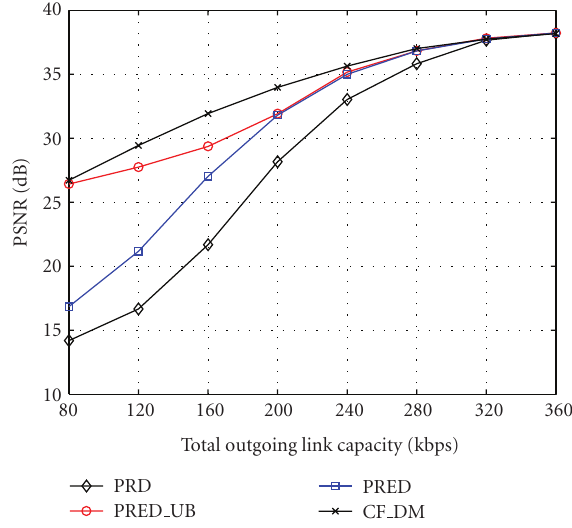
Figure 8: Performance comparison of di ff erent frame dropping schemes for streaming